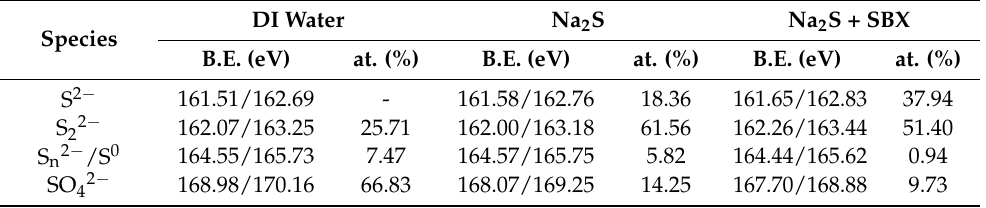
Table 2. S 2p quantification of digenite with different treatments in the absence of Fe 3+ . Table 4. Cu 2p quantification of digenite with different treatments in the presence of Fe 3+ .